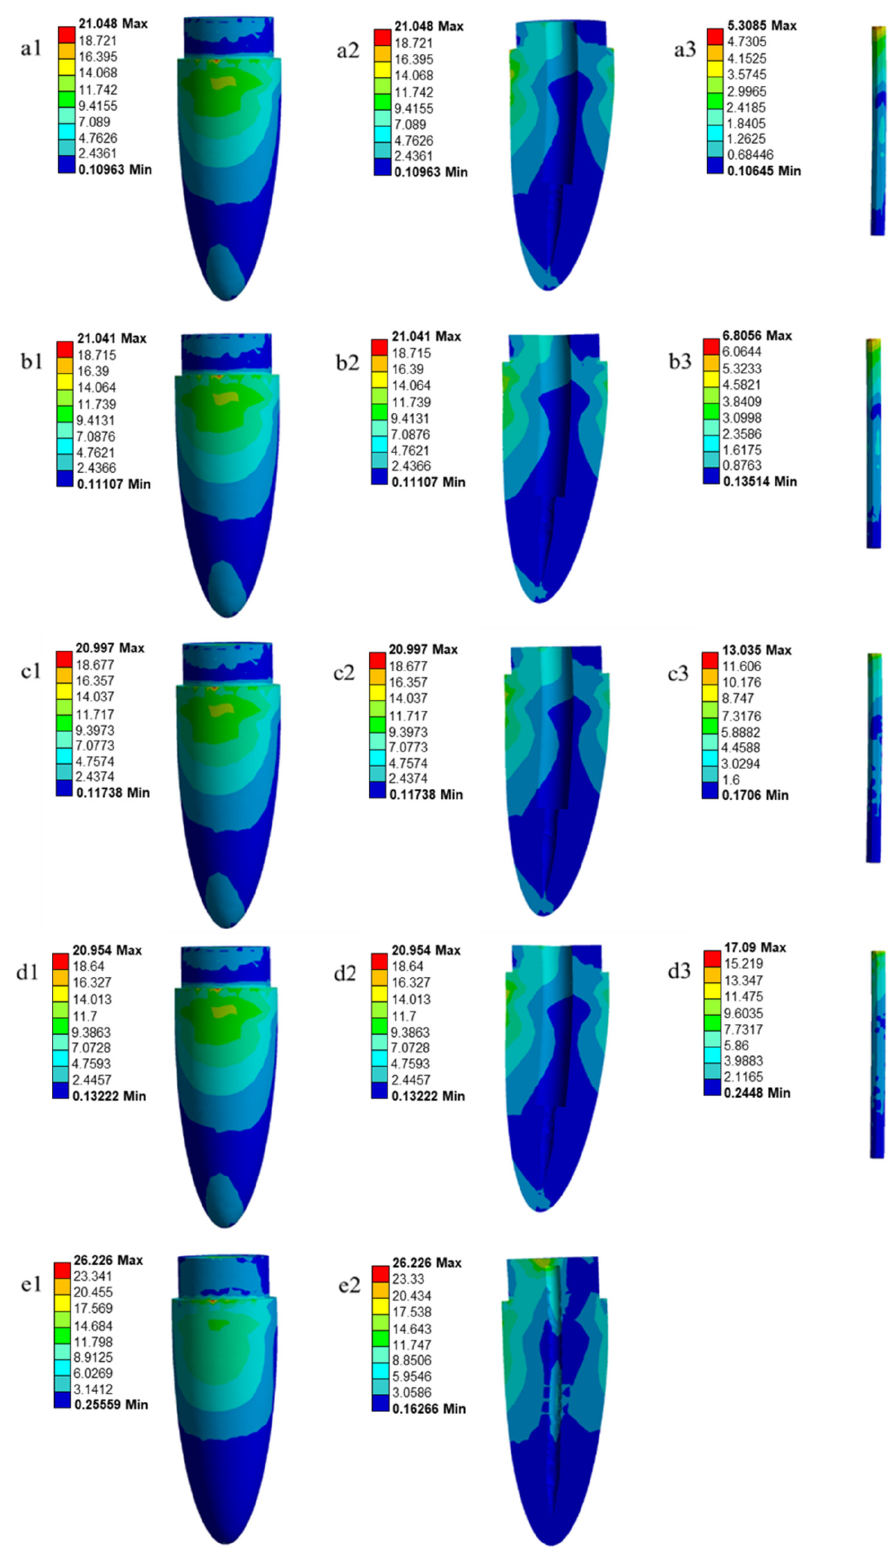
Figure 6. Contour map of the von Mises stress of tooth restored with GF-reinforced poly(BA-a) composites as a glass fiber post and natural tooth with 100 N applied load: GF-reinforced poly(BA-a) composite posts at various GF contents: ( a ) 20 wt%, ( b ) 40 wt%, ( c ) 60 wt%, ( d ) 80 wt%, ( e ) natural tooth.